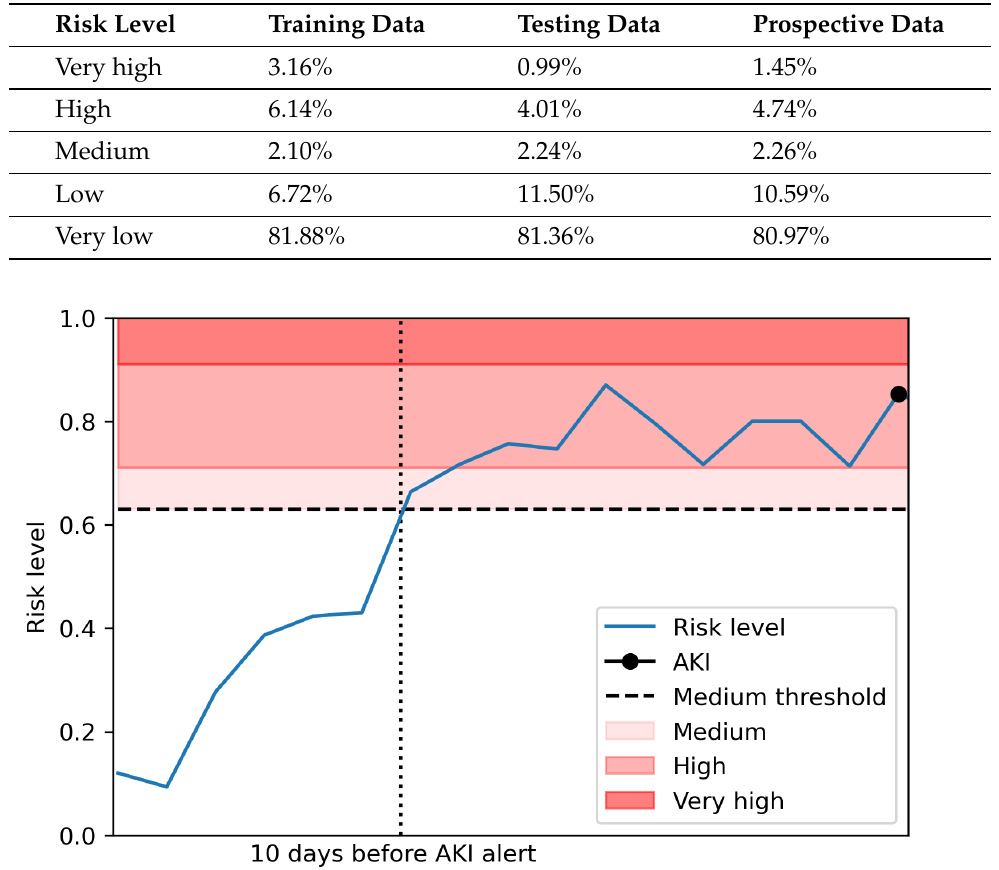
Figure 3. An example of the model’s risk level predictions. The blue line shows the risk level associated with each blood test for a patient, with that above the dashed line denoting a prediction above ‘Medium’. The sections denote ‘Medium’, ‘High’ and ‘Very high’ risk from bottom to top. The plot shows time to the next AKI for the patient with the AKI alert denoted by the black